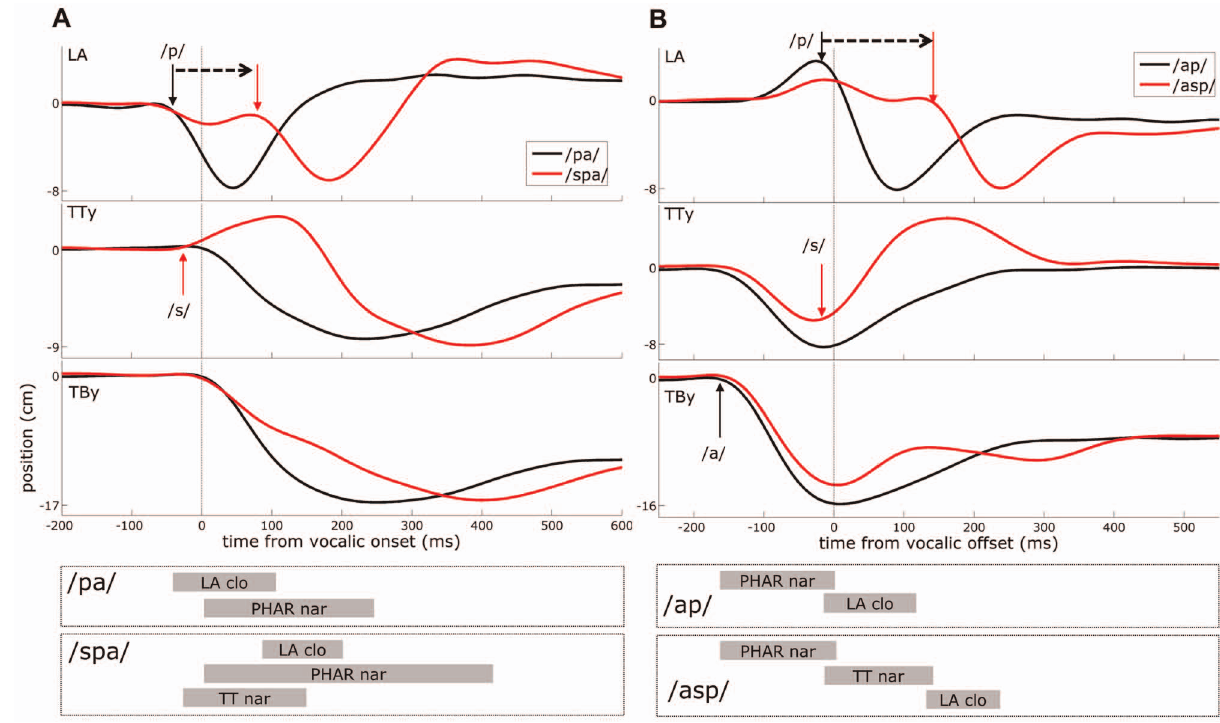
Figure 1. Illustration of articulatory coordination and sequencing. (A) onset consonantal gestures are precisely coordinated with the vocalic gesture and overlap substantially. (B) coda consonantal gestures are selected sequentially. Arrows show movement onsets. Gestural scores aligned to movement trajectories are shown for consonantal and vocalic gestures.